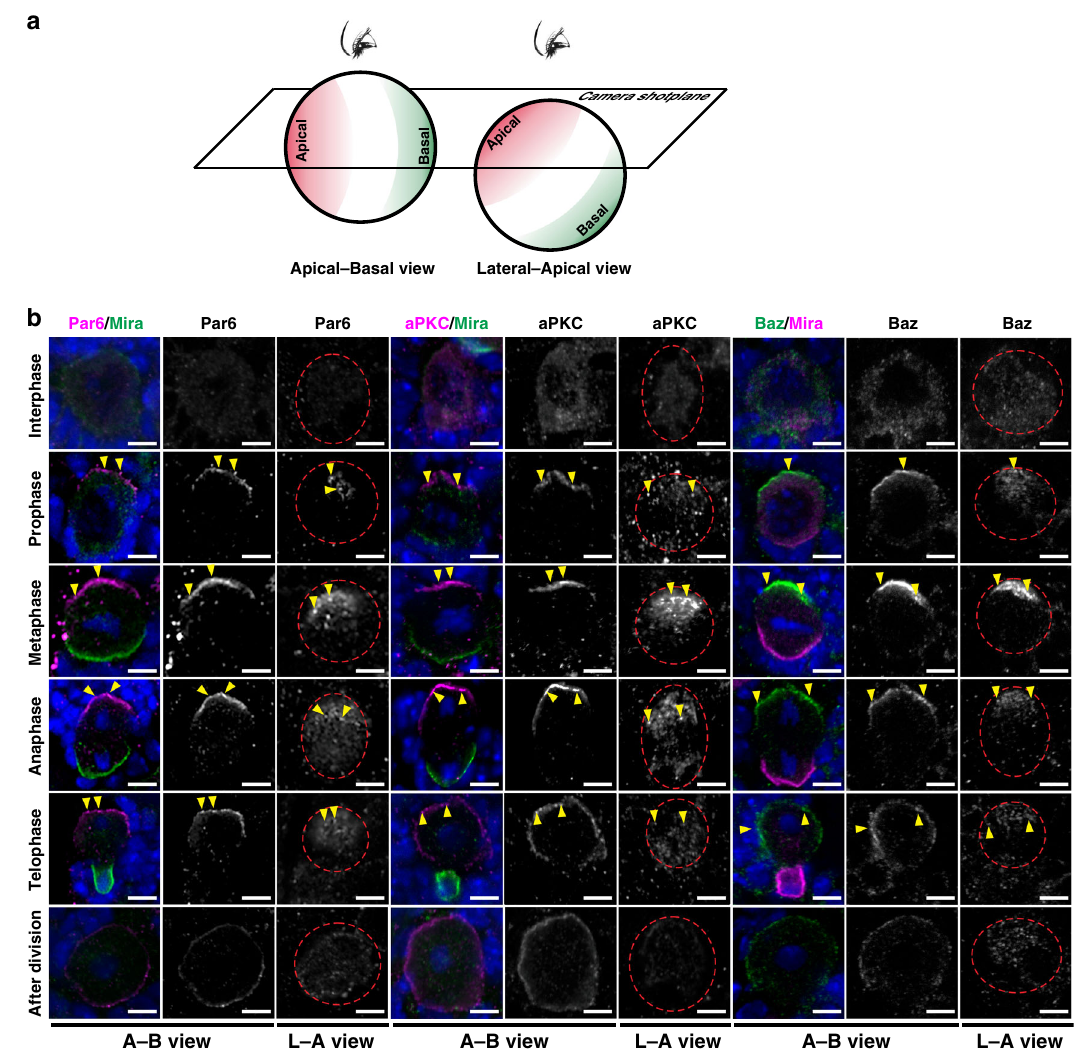
Fig. 1 Endogenous Par proteins form condensed puncta in Drosophila larval NBs in a cell cycle-dependent manner. a Schematic diagram showing the view planes. b Representative image of endogenous Baz, Par6, aPKC, and Mira at different cell cycle stages ( n = 10 neuroblasts collected from ten larval brains over three independent experiments). ToPro-3 in blue. Yellow arrowheads indicate condensed puncta on the apical cortex. Scale bars, 5 μ m. Experiments were performed three times independently with similar